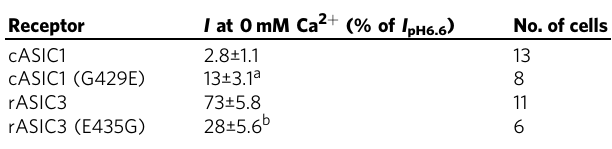
Table 1 Summary of Ca 2 + response in ASIC channels at pH 7.4 Receptor I at 0 mM Ca 2 + (% of I pH6.6 ) No. of